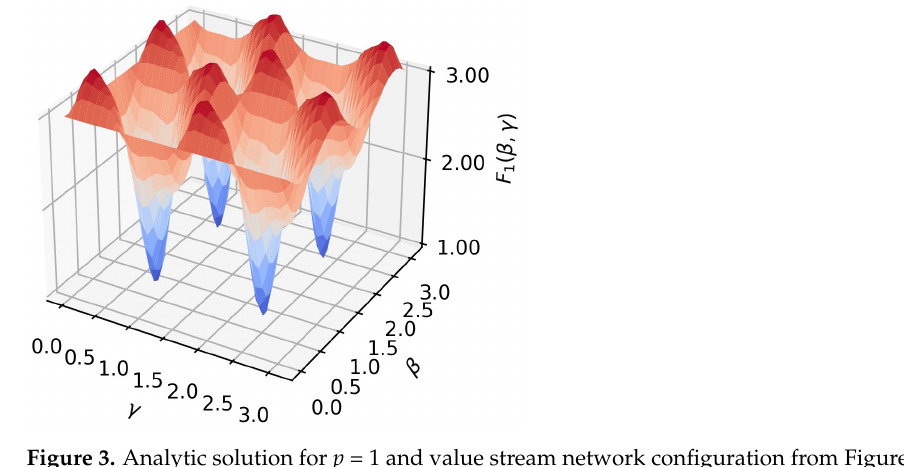
Figure 3. Analytic solution for p = 1 and value stream network configuration from Figure 2.